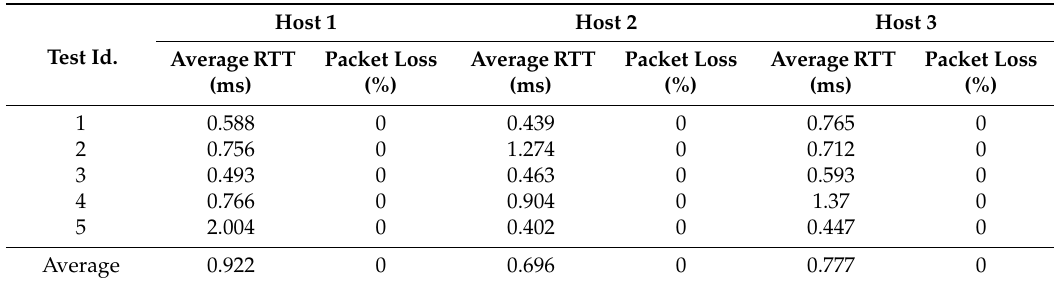
Table 3. Typical System Performance without DDoS Attack.